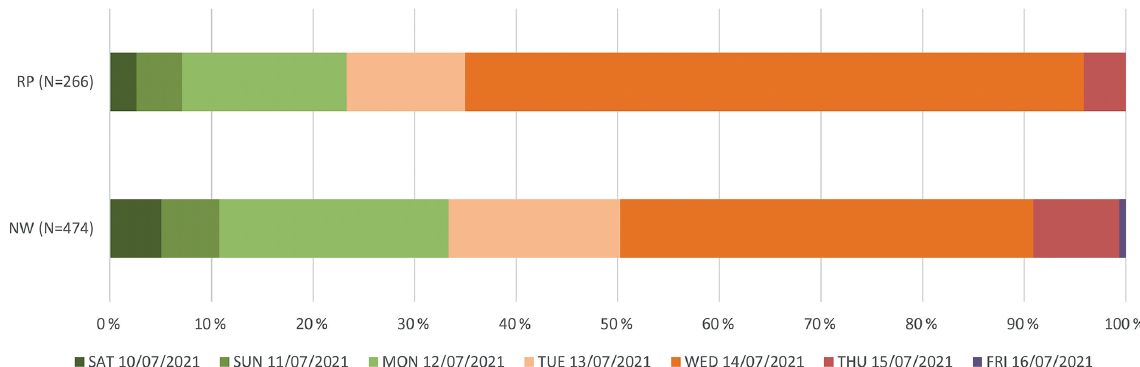
Figure 3. Day on which 740 respondents from North Rhine-Westphalia (NW) and Rhineland-Palatinate (RP) received a first warning.